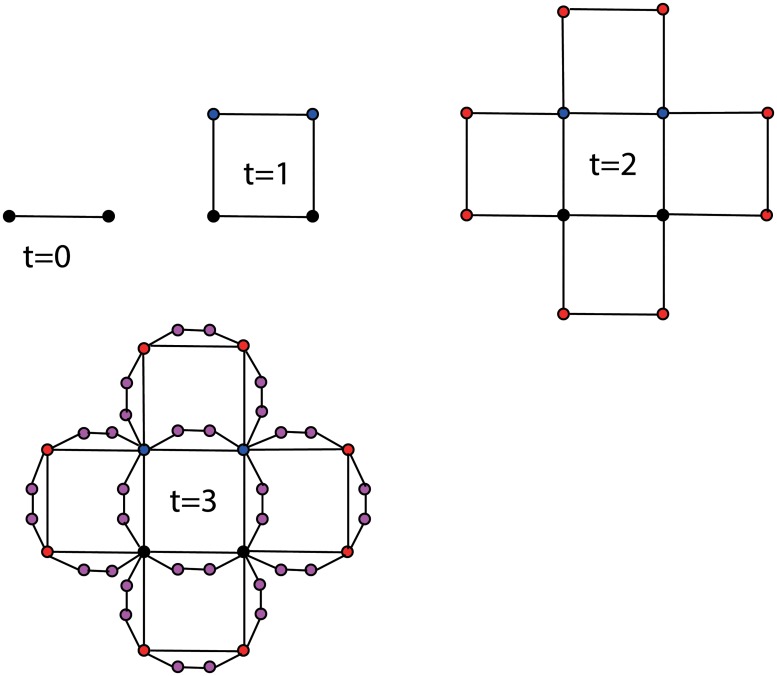
Illustration of the growing process for the (1, 3)-flower.Where, every old edge generates 2 new nodes. All of these 2 new nodes and the old edge form a circle of length 4.